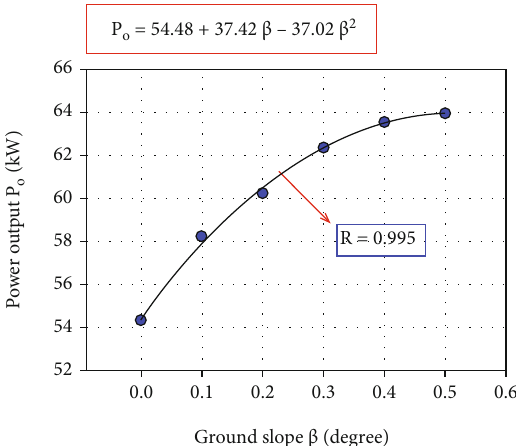
Figure 9: Power output of the pilot plant for di ff erent ground slope angles.